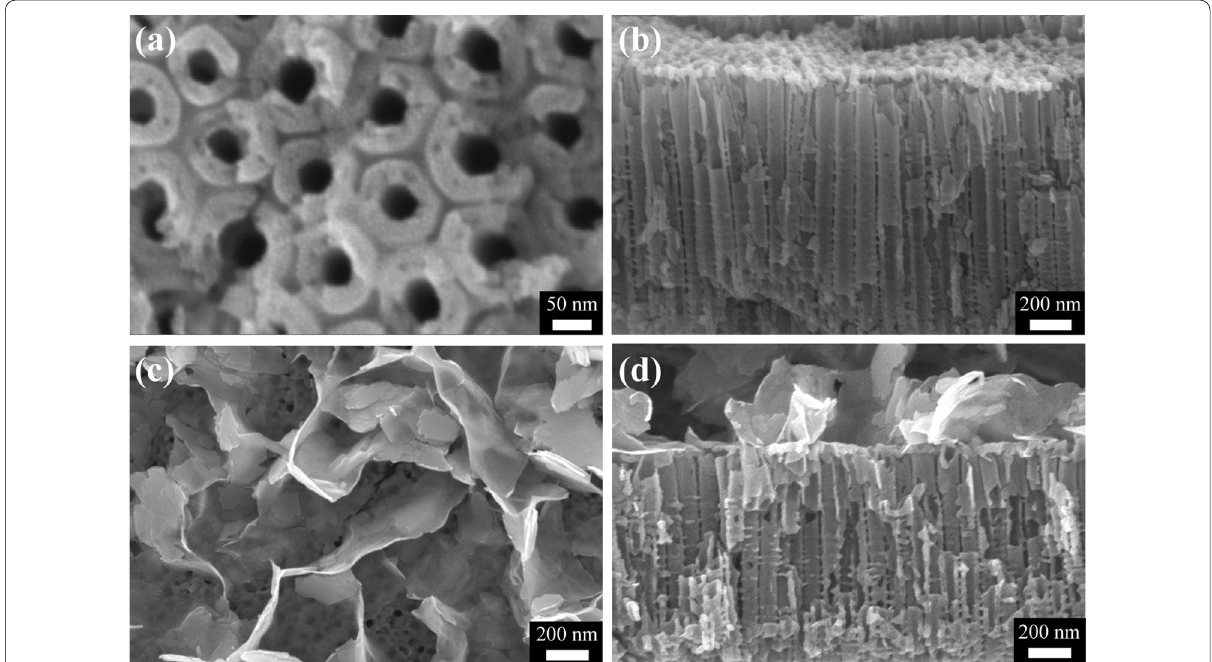
Fig. 2 a Topographic and b cross-sectional SEM images of the TiO 2 NT films, c topographic and d cross-sectional SEM images of the SnIn 4 S 8 /TiO 2 composite film